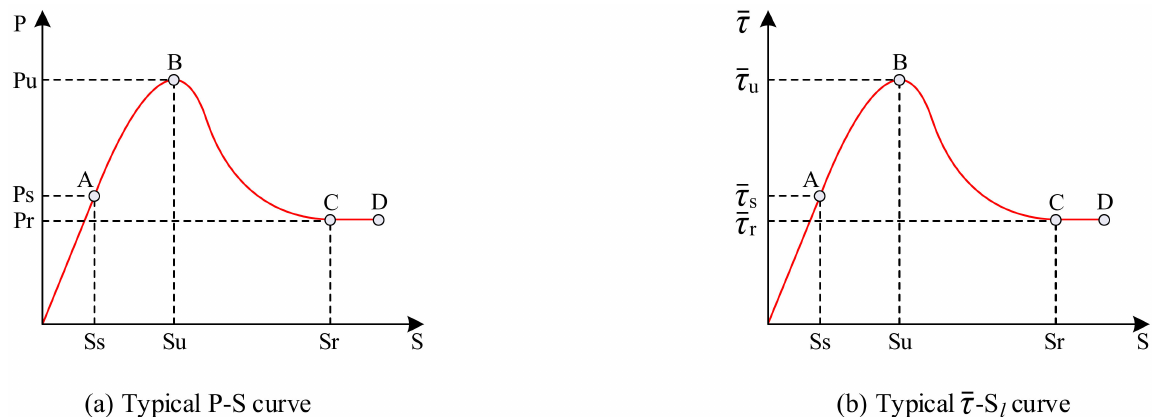
Figure 13. Typical characteristic curves.